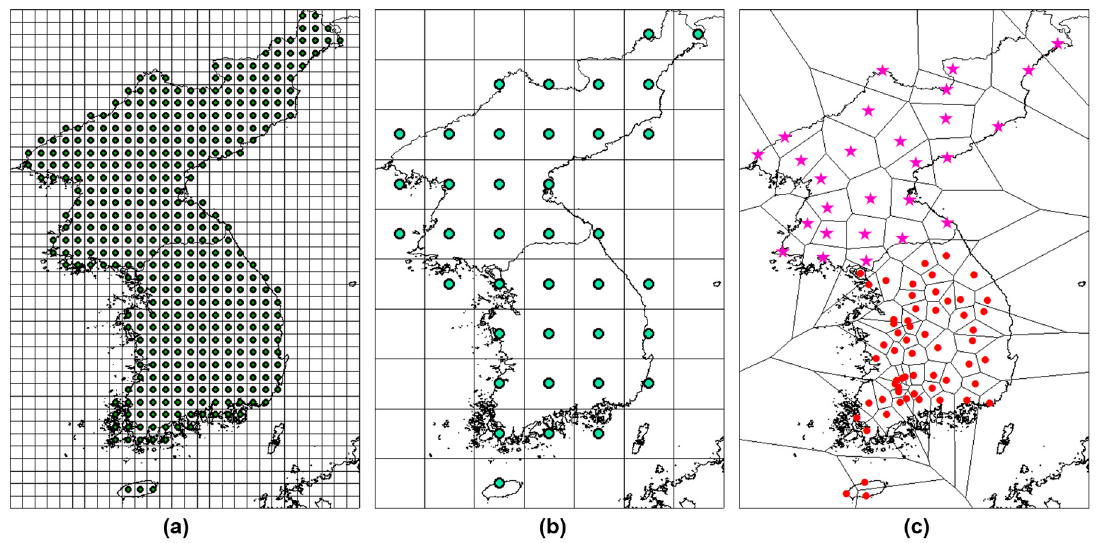
Figure 4. ( a ) The spatial resolution of TMPA3B43V7 at 0.25°; ( b ) Grid after resampling at 1.0°; ( c ) Thiessen polygons with precipitation gauging stations.